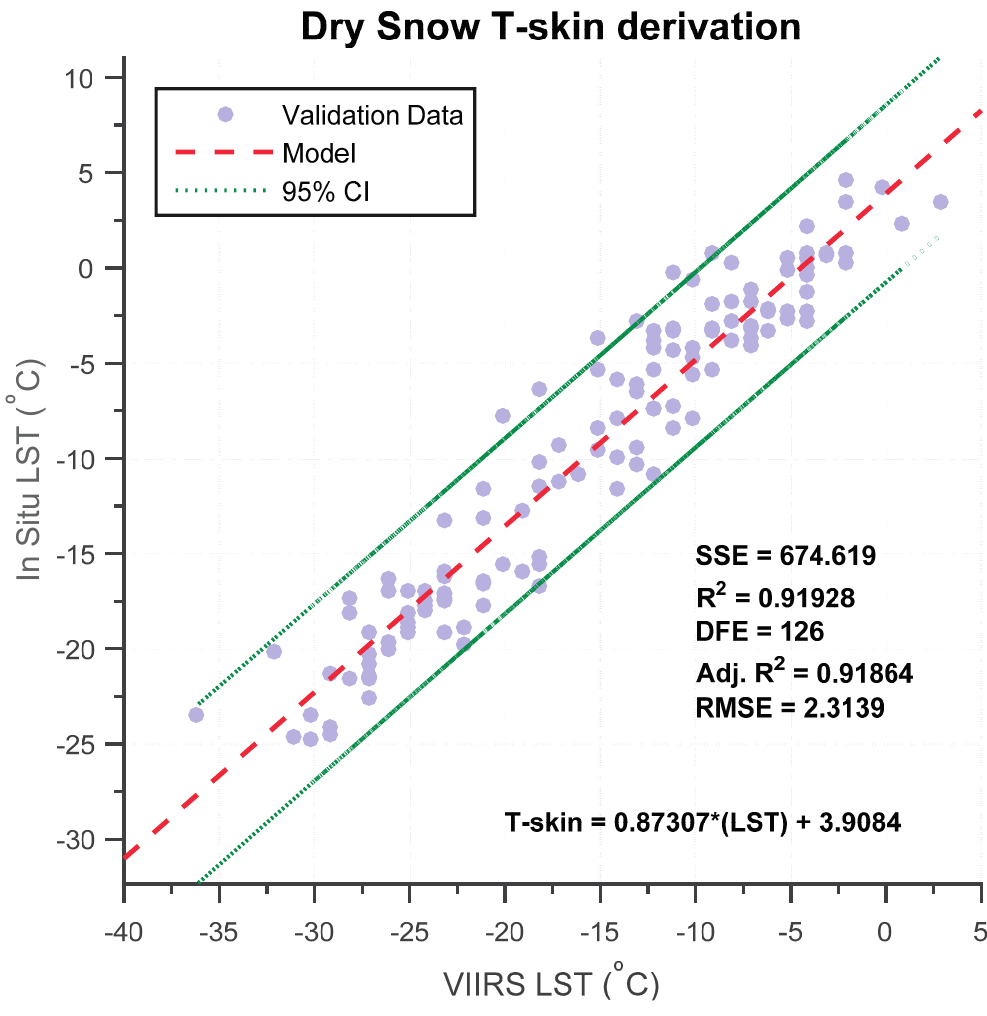
Figure 13. T-skin derived empirical formula based on linear regression model between clear-sky VIIRS LST nighttime (dry snow) views with respective in situ temperatures at